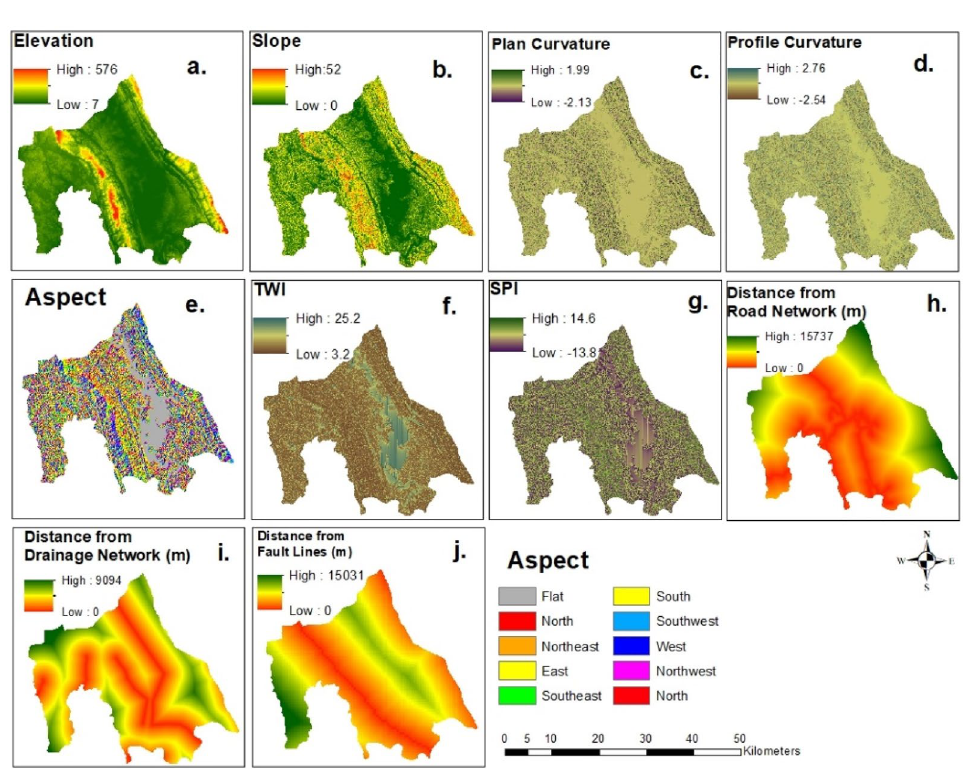
Figure 4. Landslide causal factors: ( a ) elevation; ( b ) slope; ( c ) plan curvature; ( d ) profile curvature; ( e ) aspect; ( f ) TWI; ( g ) SPI; ( h ) Distance from the road network; ( i ) distance from the drainage network; ( j ) distance from fault lines (modified from 25